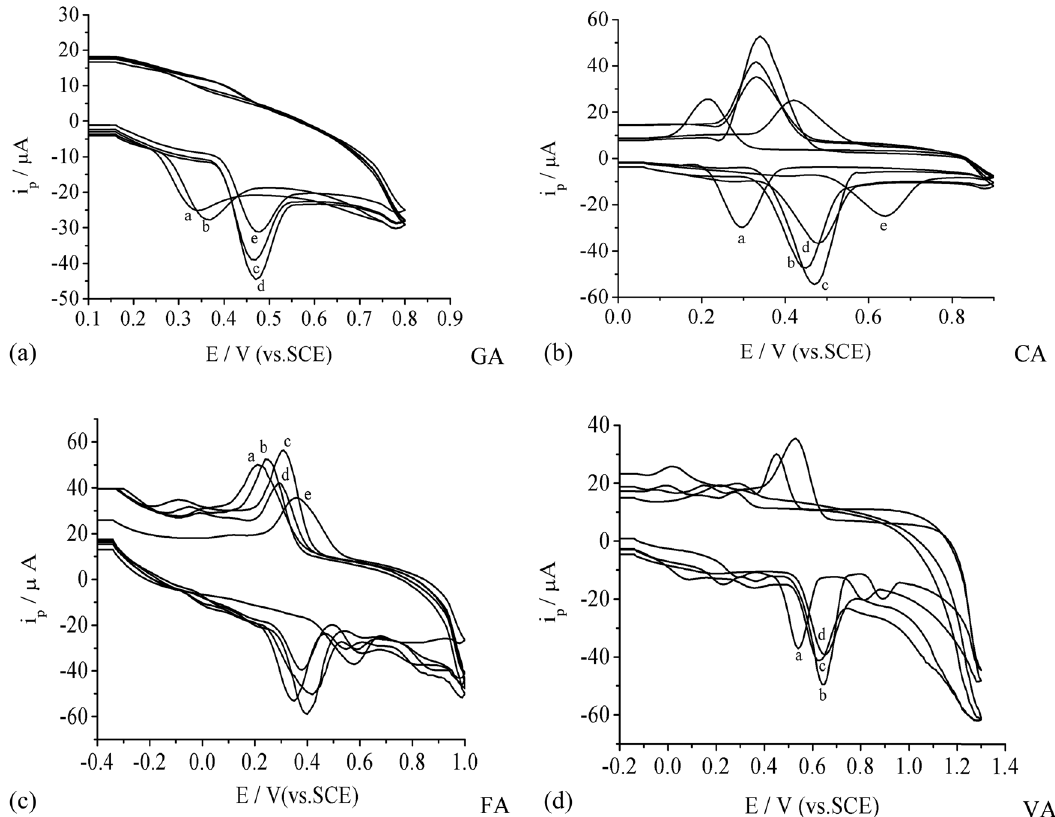
Figure 3: The in fl uence of supporting electrolyte on the redox peak current of four polyphenolic compounds. ( a (( a ) Na 2 HPO 4 – KH 2 PO 4 , ( b ) PBS, ( c ) C 6 H 8 O 7 – Na 3 C 6 H 5 O 7 , ( d ) Na 2 HPO 4 – C 6 H 8 O 7 , ( e ) HAc – NaAc, c = 0.01 mol/L and ν = 0.05 V/s )) ; ( b (( a ) C 6 H 8 O 7 – Na 3 C 6 H 5 O 7 , ( b ) PBS, ( c